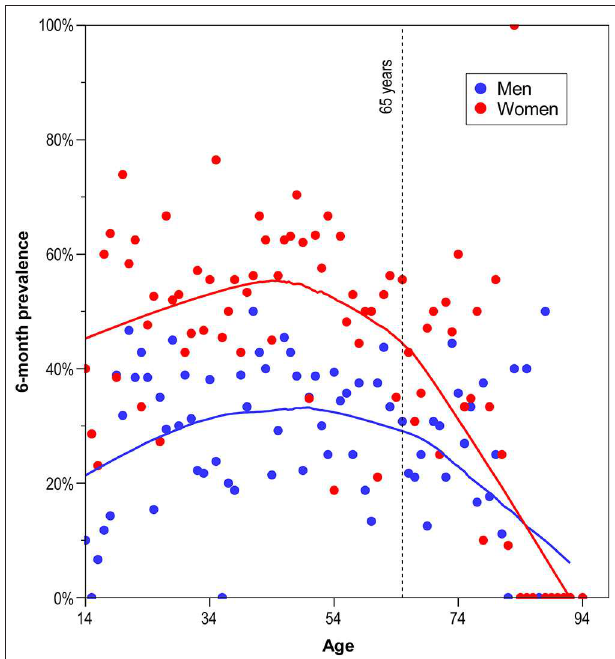
FIGURE 1 | Weighted age-specific 6-month prevalence of self-reported headache, represented by scatterplot smoothing LOESS curves for men and